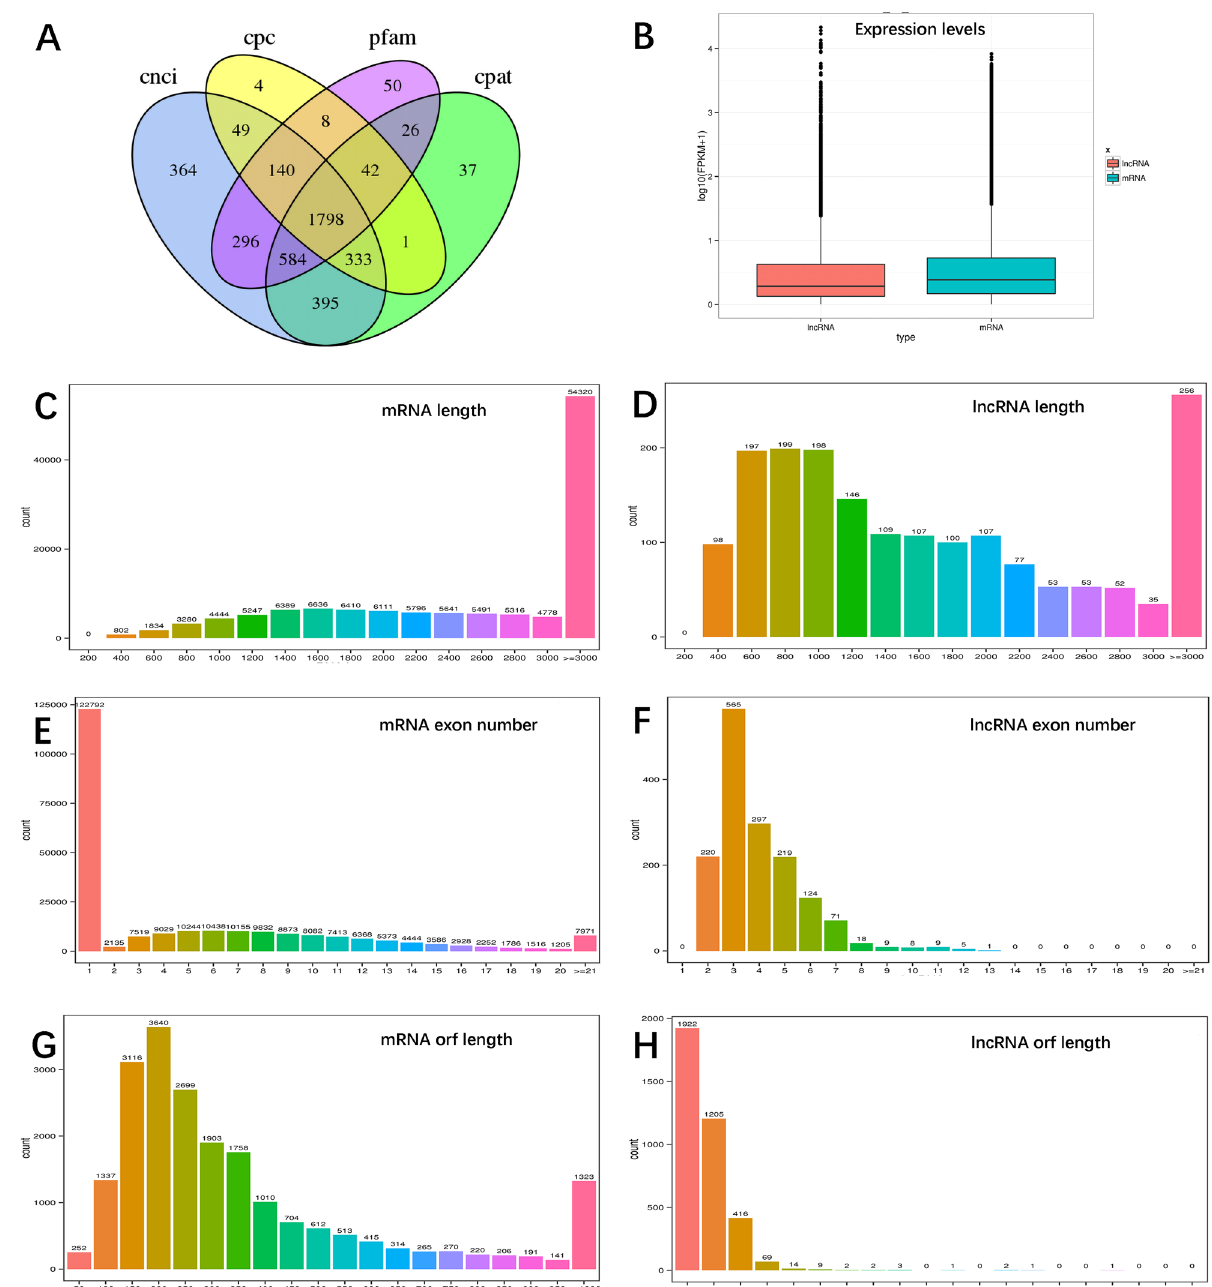
Figure 2. Identification of lncRNAs and mRNAs involved in high altitude hypoxia adaptation in lung tissue. Coding potentiality filter using CPAT/CNCI/CPC/Pfam ( A ). The boxplot shows the expression levels (log10 (FPKM + 1)) of lncRNAs and mRNAs ( B ). Transcript lengths distribution of mRNAs ( C ) and lncRNAs ( D ). Exon number distribution of mRNAs ( E ) and lncRNAs ( F ). Open reading frame (ORF) length distribution of mRNAs ( G ) and lncRNAs ( H